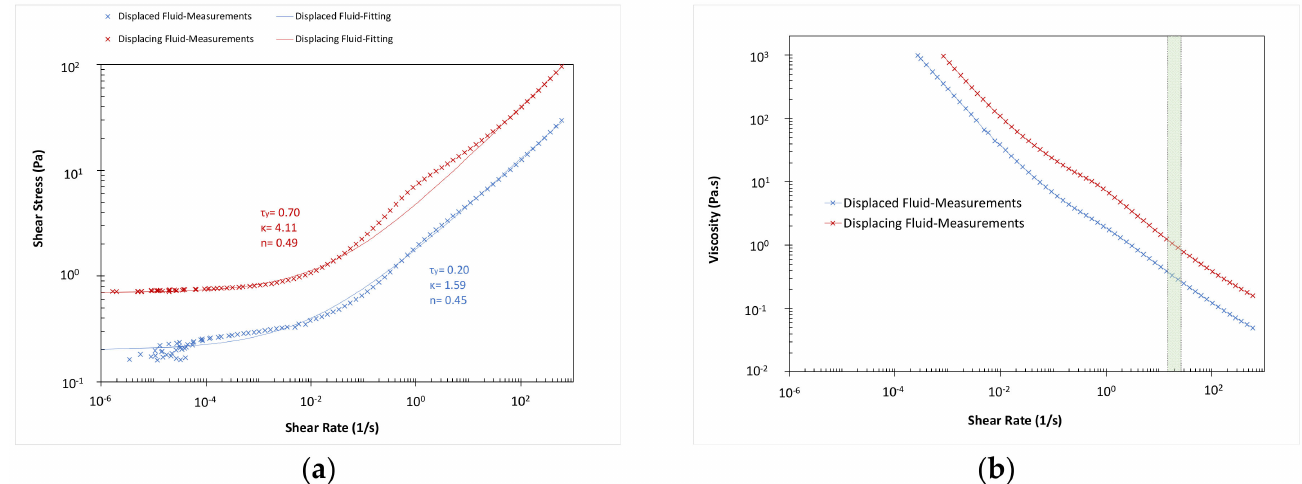
Figure 10. Rheological behavior of the displaced and displacing fluids in tests no. 6, 7 and 8. ( a ) Flow curve; ( b ) equivalent viscosity.